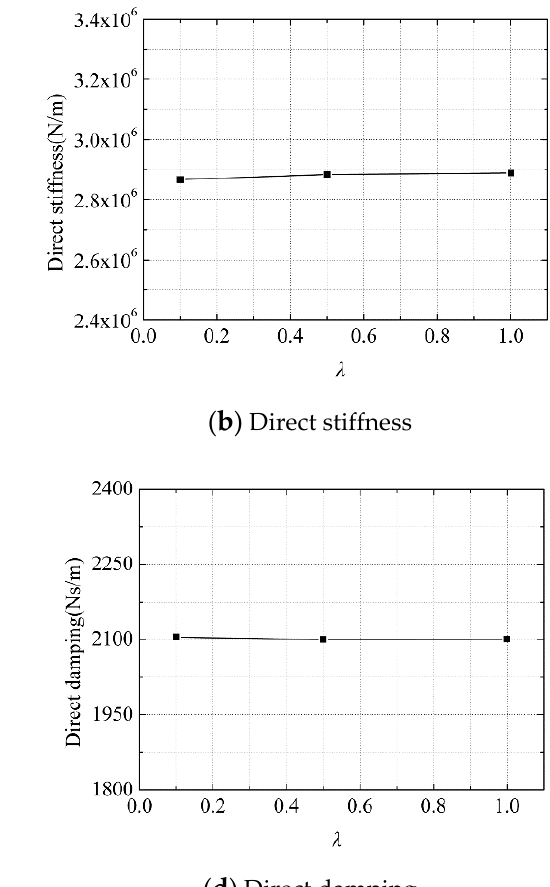
Figure 16. Three typical whirl orbits.